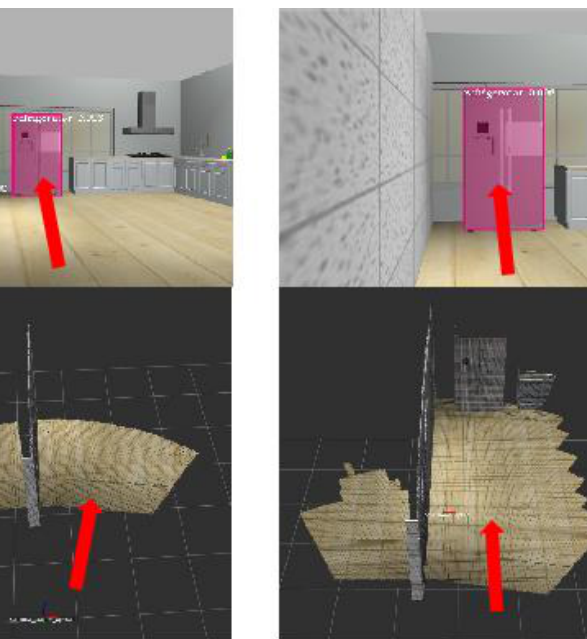
Figure 12. The process of the robot navigating to the cup.